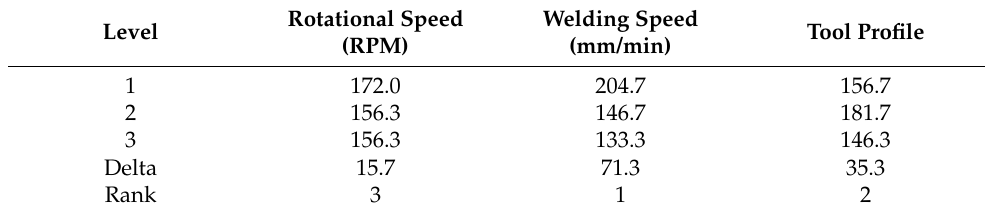
Table 3. Response table for means for tensile strength.